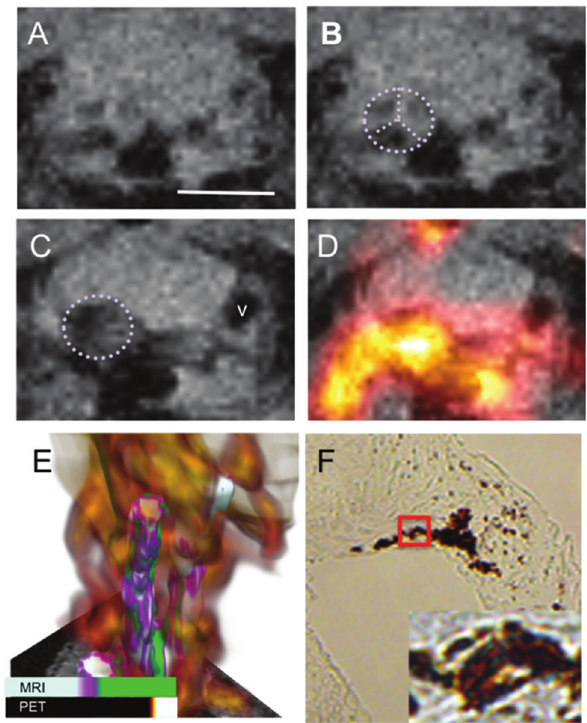
Figure 1. Multimodal nanoparticle probes are taken up by macrophages in the aortic valve of ApoE 2 / 2 mice with vascular inflammation induced by ligation. (A) The aortic valve before administration of probes. Scale bar =2.5 mm. (B) Position of the aortic valve is indicated by the dotted purple lines. The three leaflets of the valve are clearly evident. (C) The MR signal intensity in and around the aortic valve (dotted outline) decreases after introduction of the multimodal PET/T2-MRI probes, shown 24 h post injection. (D) Coregistration of the PET data with the MRI data illustrates that the PET signal correlates with a broad region including and around the aortic valve. In A–D to determine the grayscale intensity of each pixel in the image and the color intensity of the PET signal, we use bilinear interpolation between the four nearest voxels in the slice. This resampling provides a smoother reconstruction without excessive blurring or loss of data. (E) 3D reconstruction of MRI and PET data shows that the PET signal intensity is a diffuse cloud (orange-yellow) broadly localized around the aortic arch and carotid arteries. This 3D image was generated by combining three different rendering models; details provided in Materials and Methods S1. F) Immunohistochemistry demonstrates that the nanoparticulate probes are localized to macrophages in the aortic arch. Macrophage presence in the aortic valve leaflets is confirmed by positive HRP reaction with DAB, macrophages = brown stain (10X magnification). The region in the red box is shown at higher magnification in the inset image (60X) and demonstrates that the iron oxide particles, stained blue, overlap with regions staining for macrophages